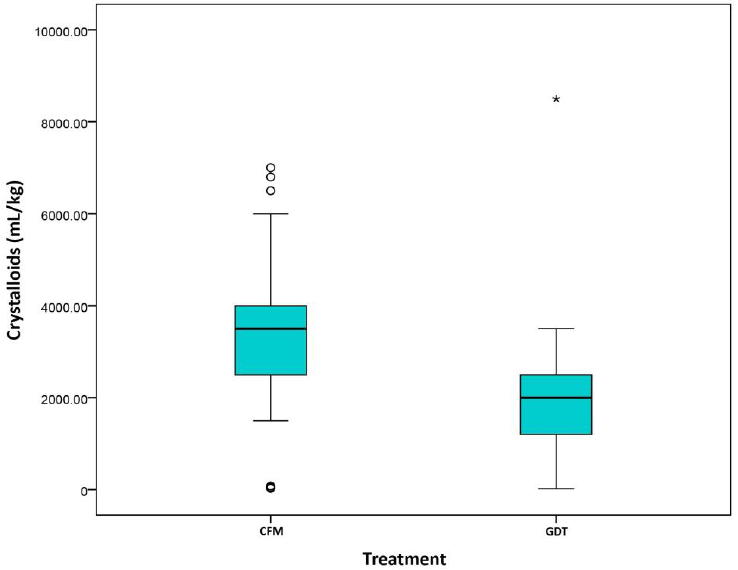
Figure 2. Crystalloids (mL/kg) (Day 1). Classical fluid management (CMF)/Goal directed therapy (GDT).